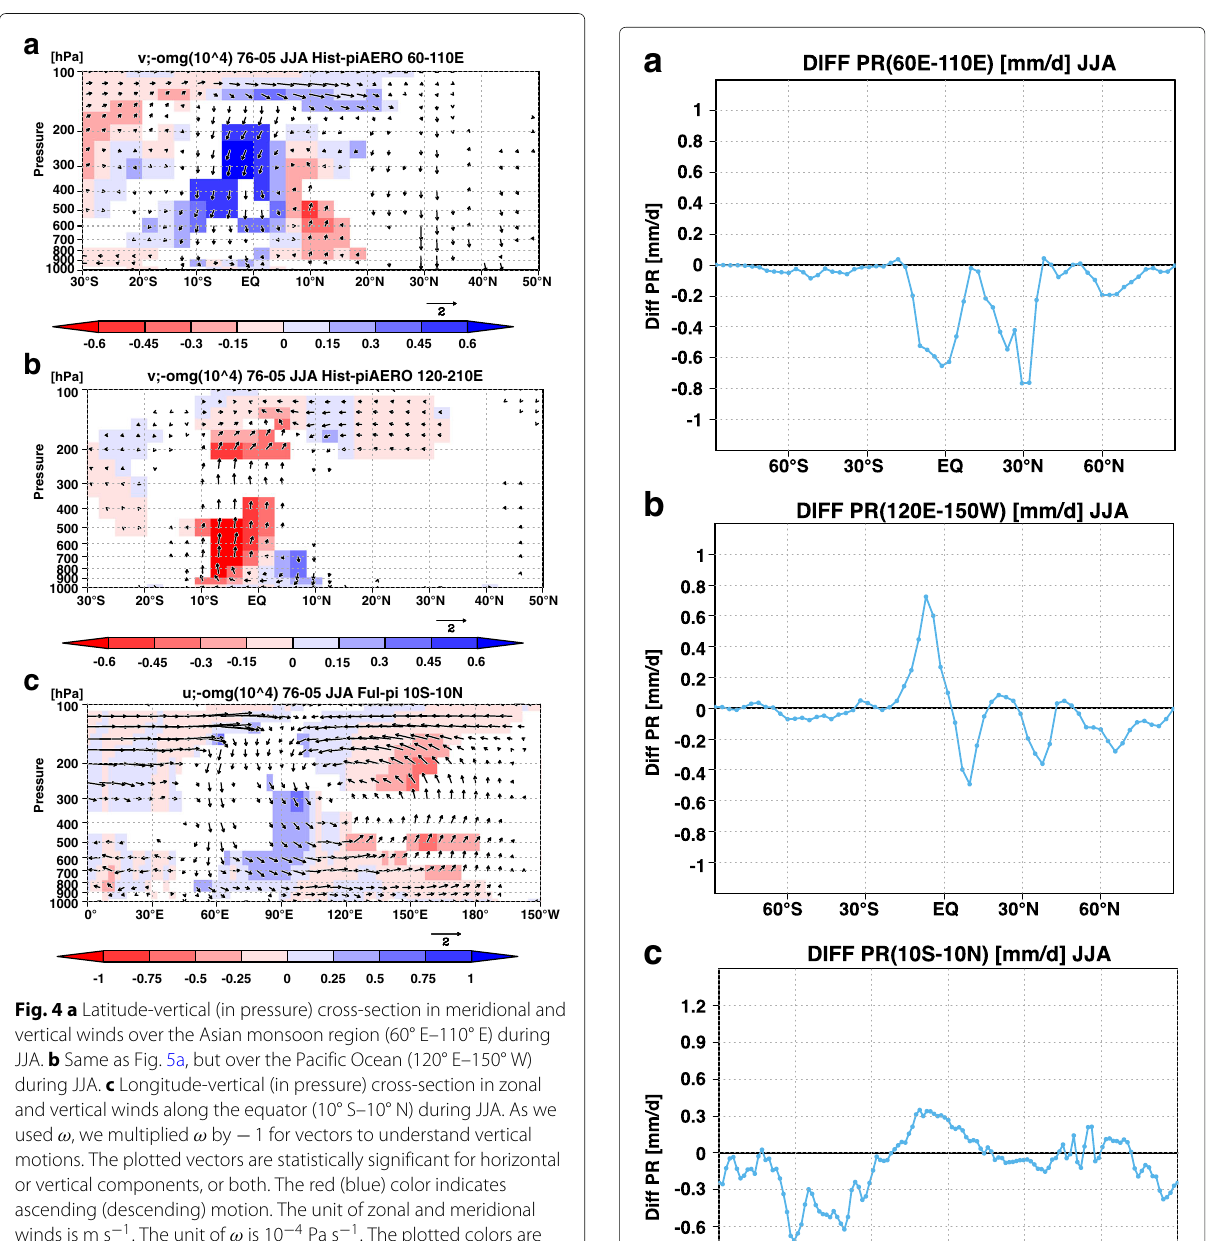
Changes in atmospheric circulation and coupling with clouds and precipitation To understand the changes in meridional and zonal cir- culation on the Asian monsoon regional scale, we pro- duced meridional-vertical cross-sections of winds over the Asian monsoon region and the Pacific Ocean, and a zonal-vertical cross-section of winds along the equato- rial region (Fig. 4). To associate atmospheric circulation changes with the precipitation changes, we analyzed zonal and meridional averaged changes in precipitation (Fig. 5).